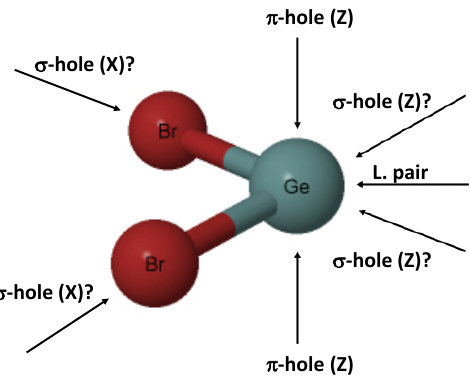
Scheme 1. The Lewis acid-base sites for the dihalometallylene (example of dibromogermylene is presented). The designations of this scheme are the same as those in Table 1. Table 1. The values of electrostatic potential, EP (in au), for dihalometallylenes; the results of MP2/aug-cc-pVTZ calculations, Z = C, Si, Ge, Sn, Pb; X = Cl, Br. L. pair designates the site corre- sponding to the location of the lone electron pair, the EP values at the σ -hole and π -hole sites of the tetrel (Z) and halogen (X) centers are given (see Scheme